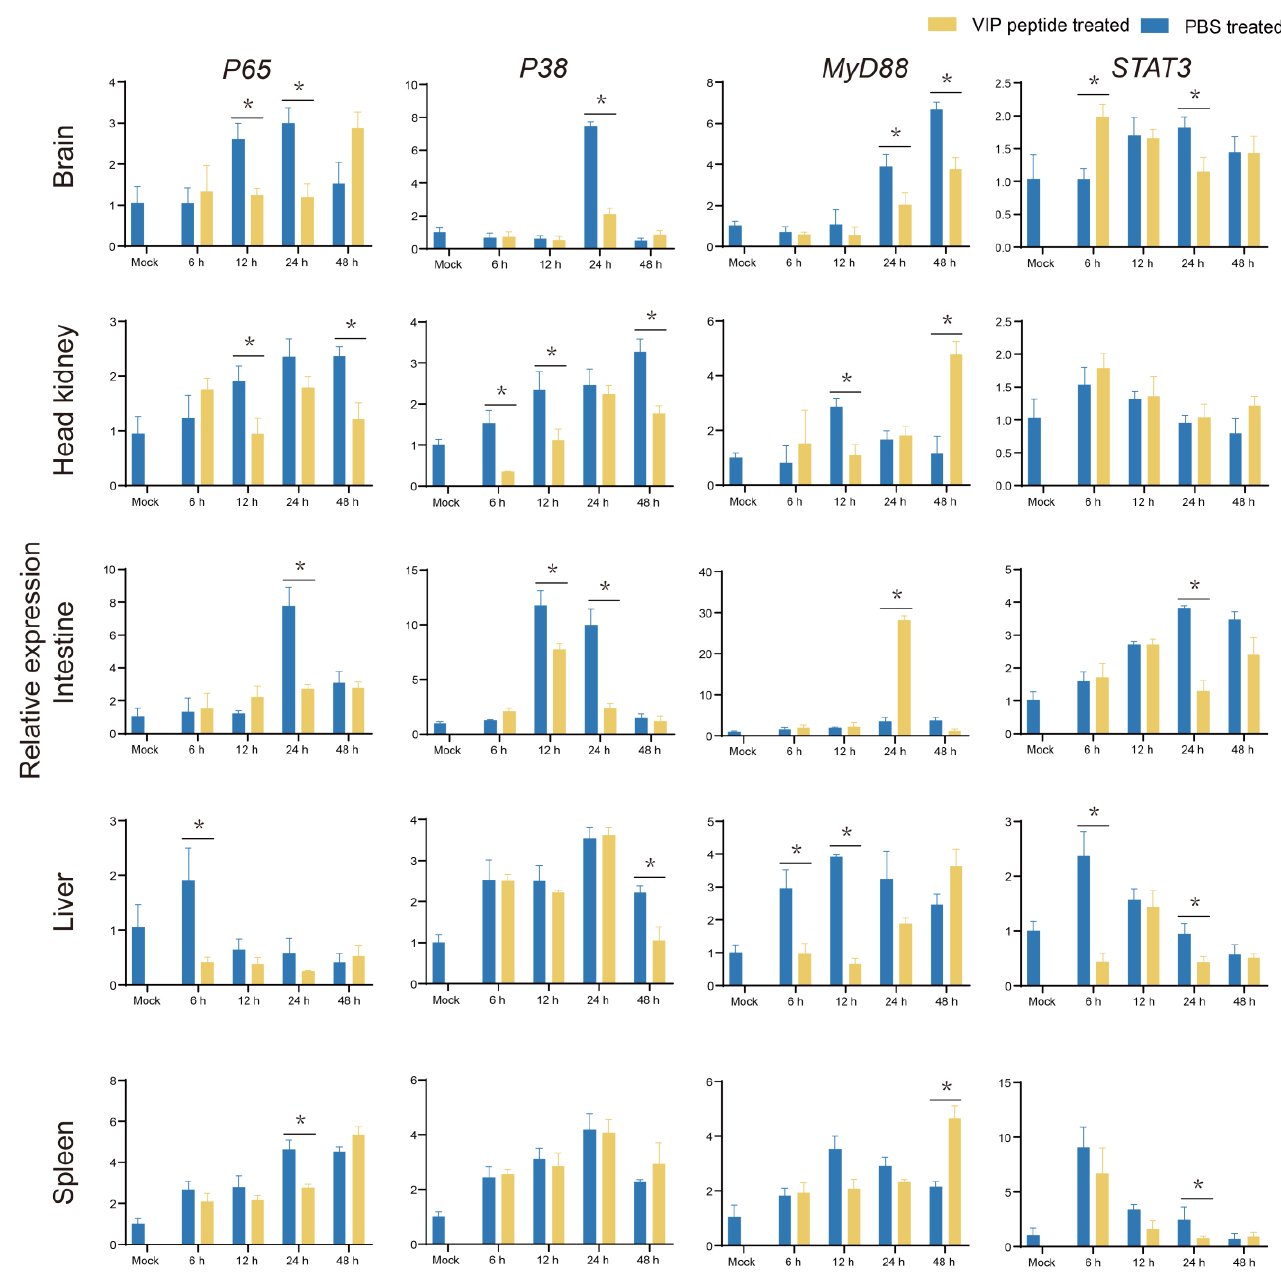
Figure 9. The expression profiles of immune-related pathways ( P65 , P38 , MYD88 , and STAT3 ) at various points after S. agalactiae infection via qRT-PCR. Every value is presented as the mean and standard deviation; n = 3. The asterisks reveal the significant difference ( p < 0.05).